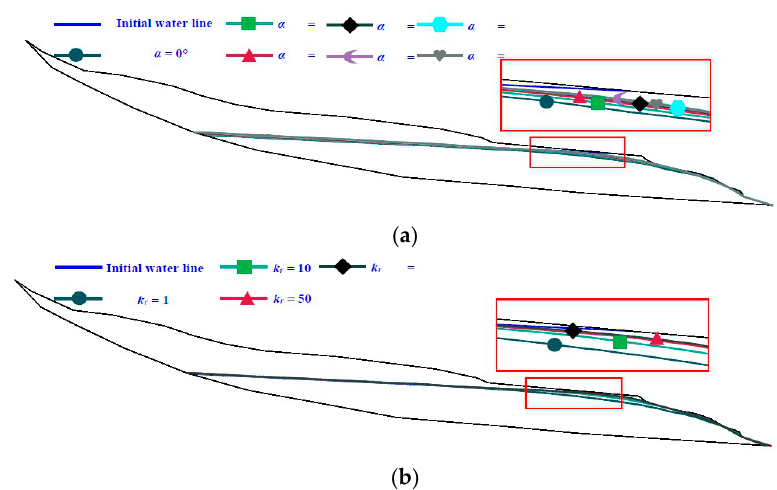
Figure 6. Effect of k r and α of clay slope on the variations of infiltration lines. ( a ) Different α values with k r = 10. ( b ) Different k r values with α = 45°.